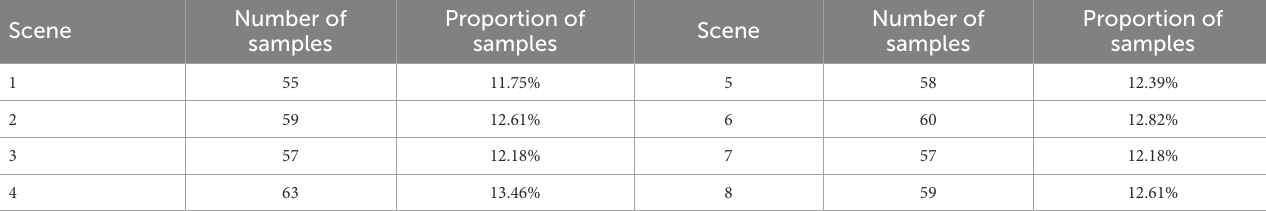
TABLE 7 Sample distribution.